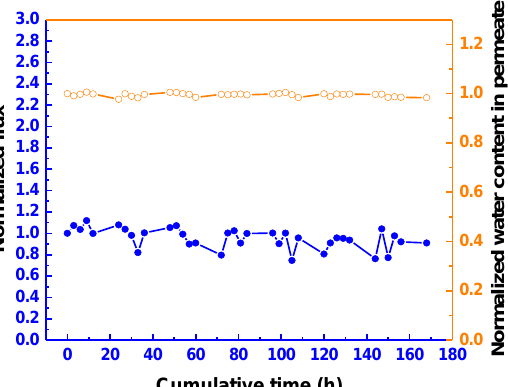
Figure 10. Membrane performance at different operating temperatures, in terms of ( a ) permeation flux and water concentration in permeate and ( b ) separation factor. APTMOS/CHDA ratio = 0.15; mixing time = 60 min; reaction temperature = 30 °C; concentration of IPA = 70 wt%; and downstream pressure = 1 mmHg.